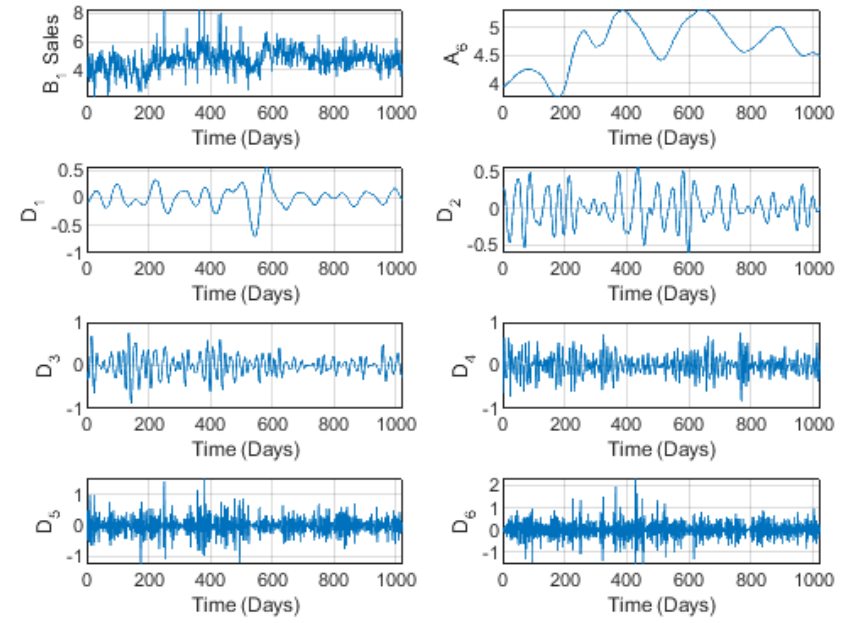
Figure 2. The wavelet decomposition of the Jarir brand B 1 sales at level